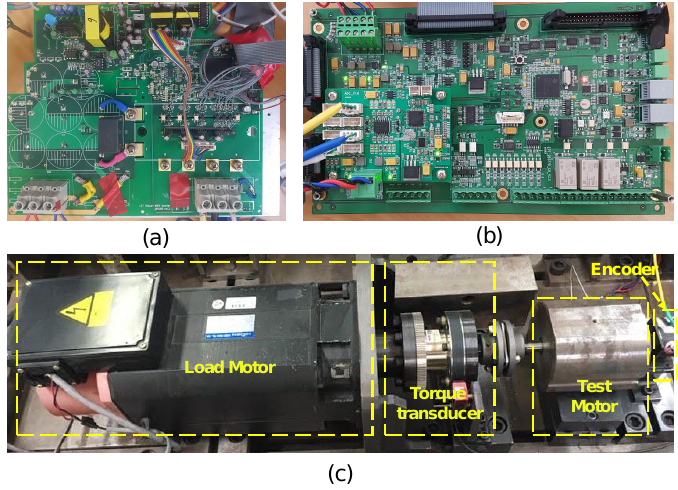
Figure 5. Experimental environments: ( a ) inverter ( b ) control board, and ( c ) test bench. Typically, the d - q axis inductance of PMSM varies significantly along with core satura- tion, due to the stator current. The variation causes a difference between the real value and the inductance parameter used in the observer. It makes the estimated angle offset